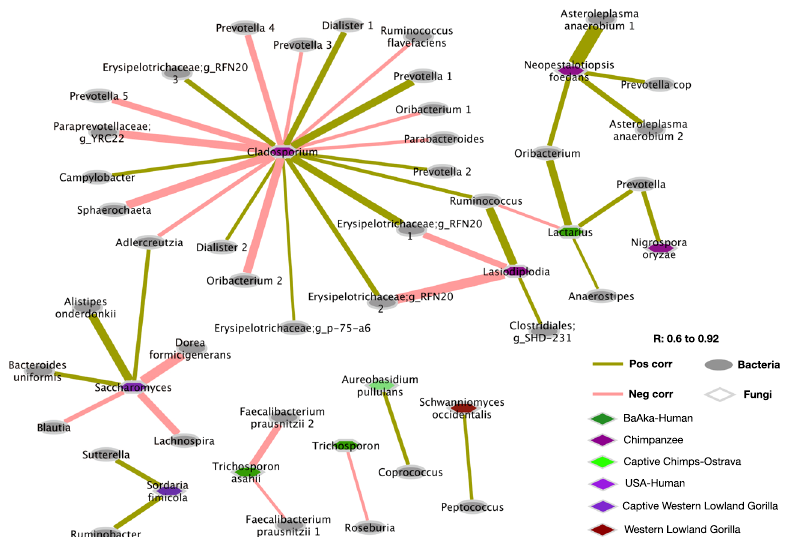
Fig. 5 Associations between bacterial taxa and representative fungal genus of individual primate groups. Compositional based correlations between all ASVs of signi fi cantly discriminating (species indicator analysis, p < 0.01) fungal genus and bacterial ASVs to show co- occurring (pairs connected using citrus color) and co-exclusive (pairs connected using light salmon pink) fungal bacterial pairs. Color code in the bottom of the plot shows the enrichment of fungal genus in respective primate groups. Shape of the node represents bacterial and fungal ASVs. Edge thickness represents correlation